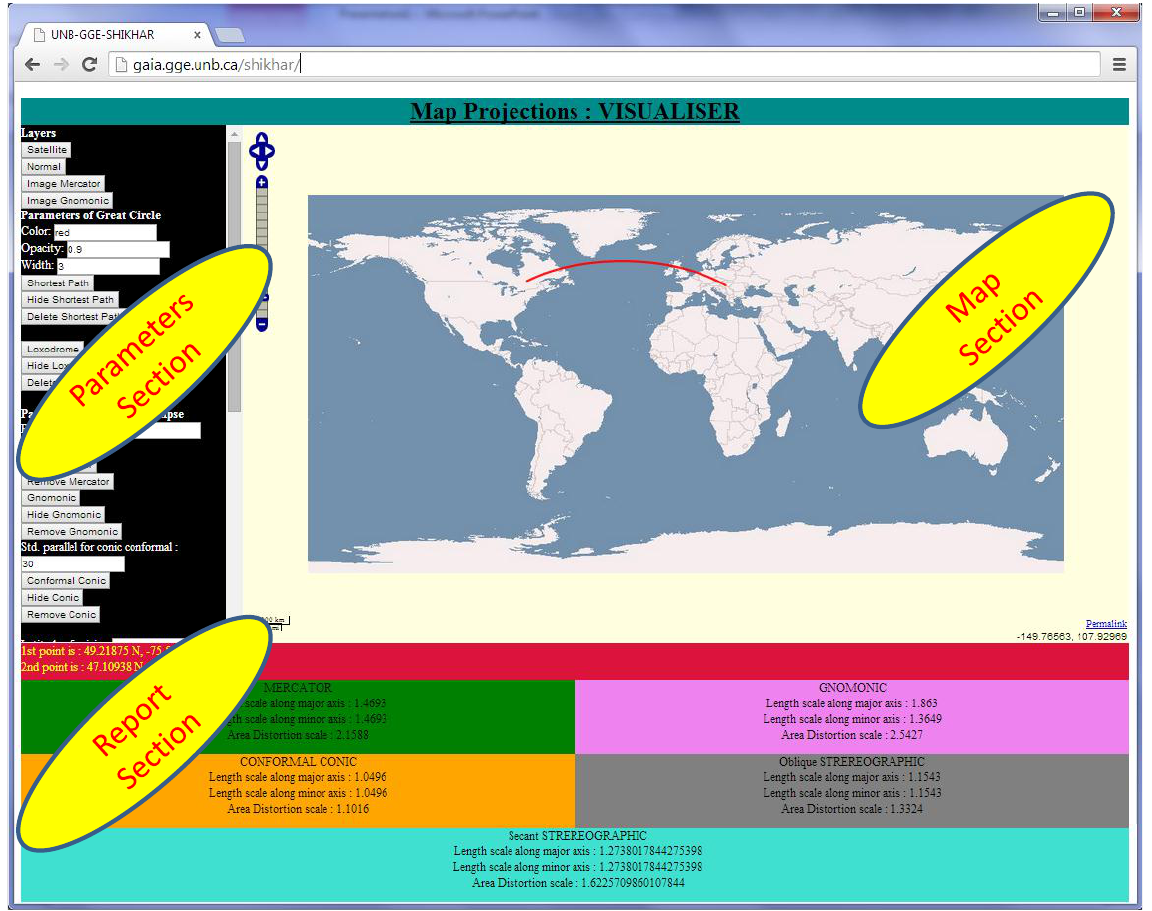
Figure 2. The main interface of the application (currently accessible at: